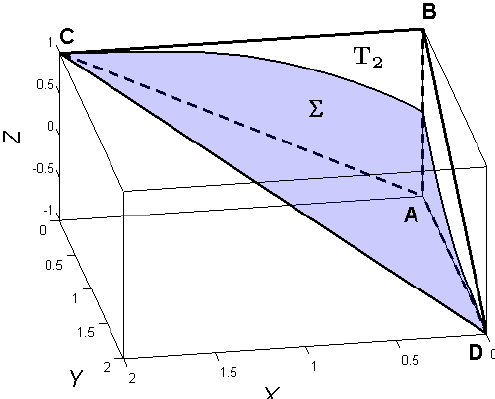
Figure 3. The surface (cid:54) divides the sticking region T in two subsets T 1 (below) and T 2 (above), which determine the first slipping mode of the seismic event ( α = 1, β = 1).